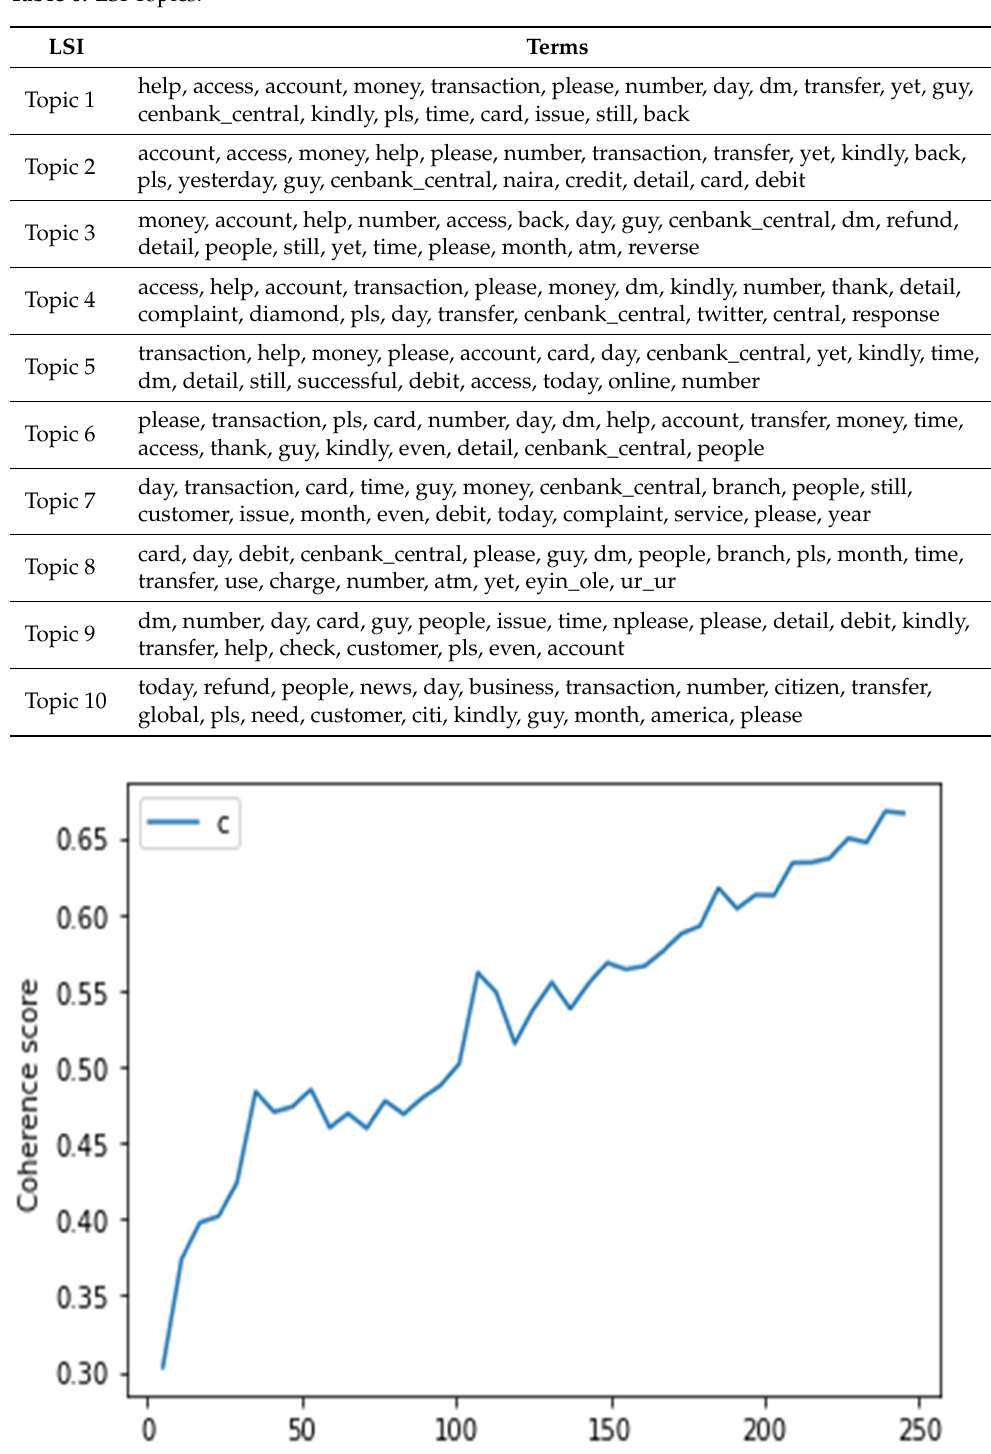
Table 7. BERTopic coherence score.